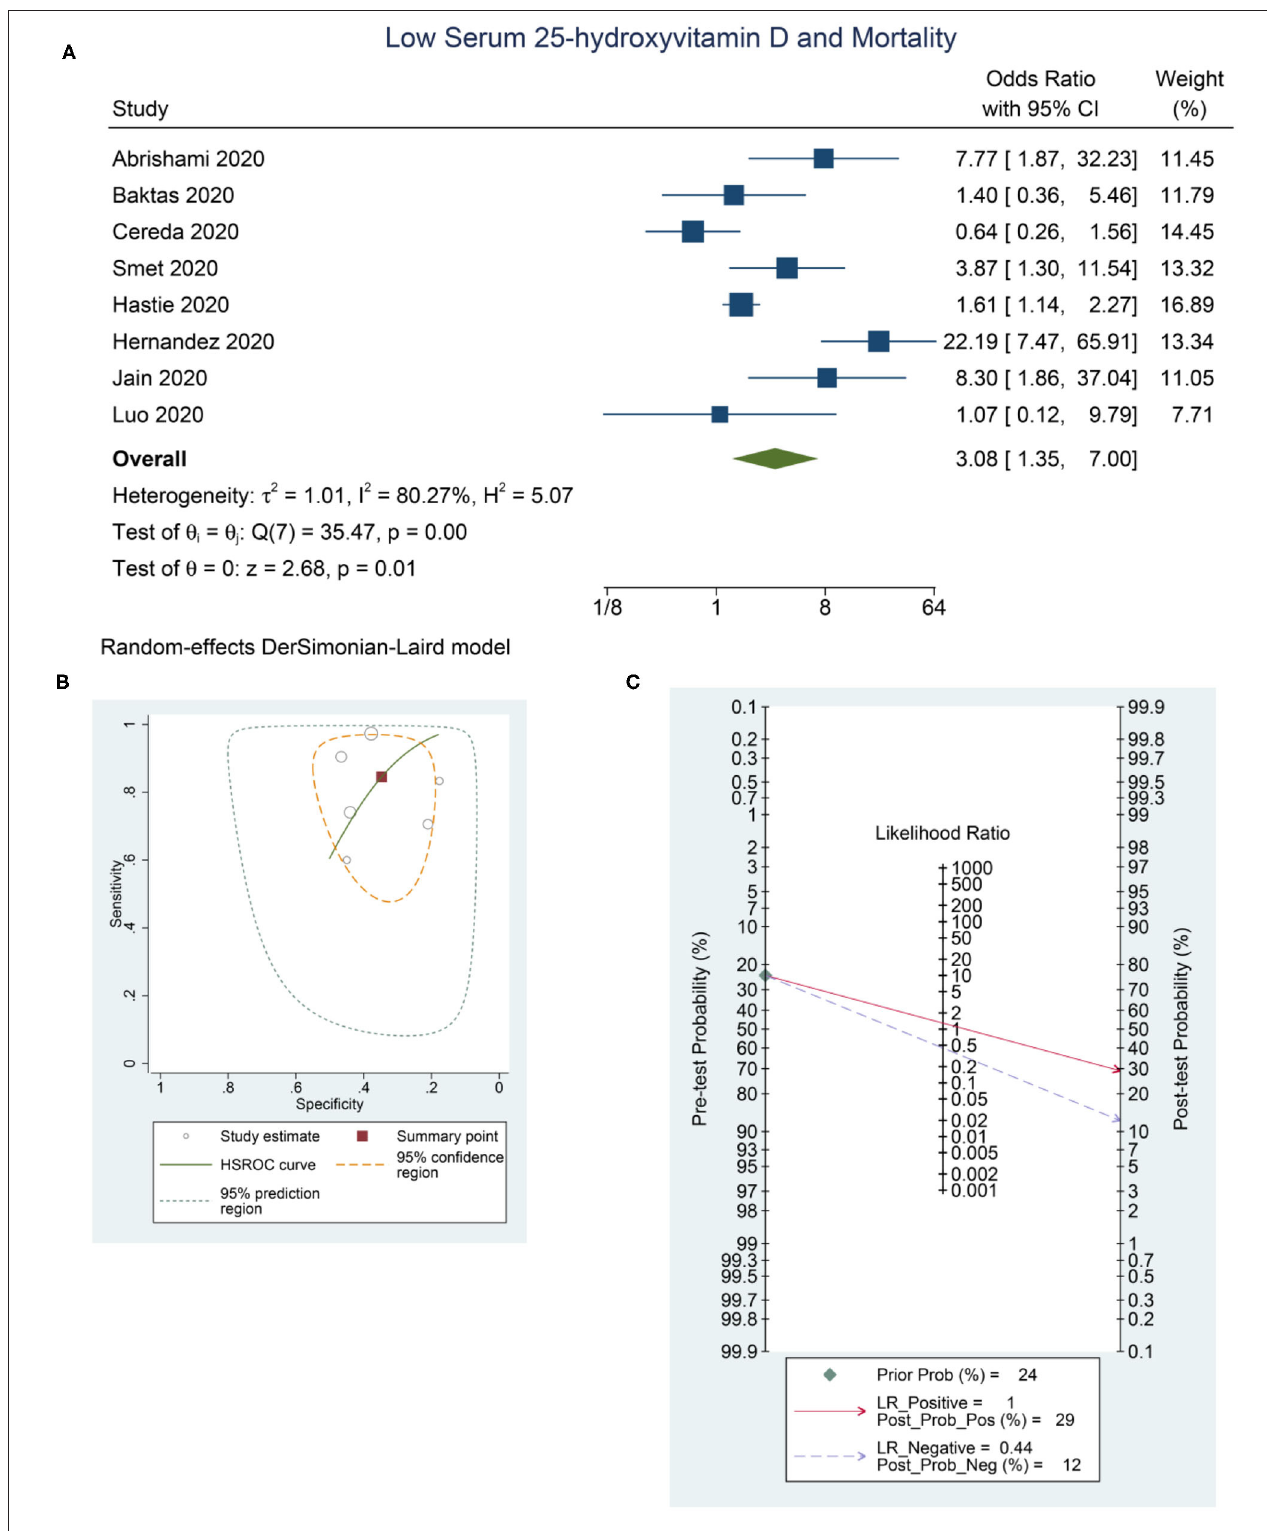
FIGURE 4 | Low Serum 25-hydroxyvitamin D and Mortality. Forest-plot (A) , HSROC curve (B) , and Fagan’s Nomogram (C) . HSROC, hierarchical summary receiver operating characteristic.